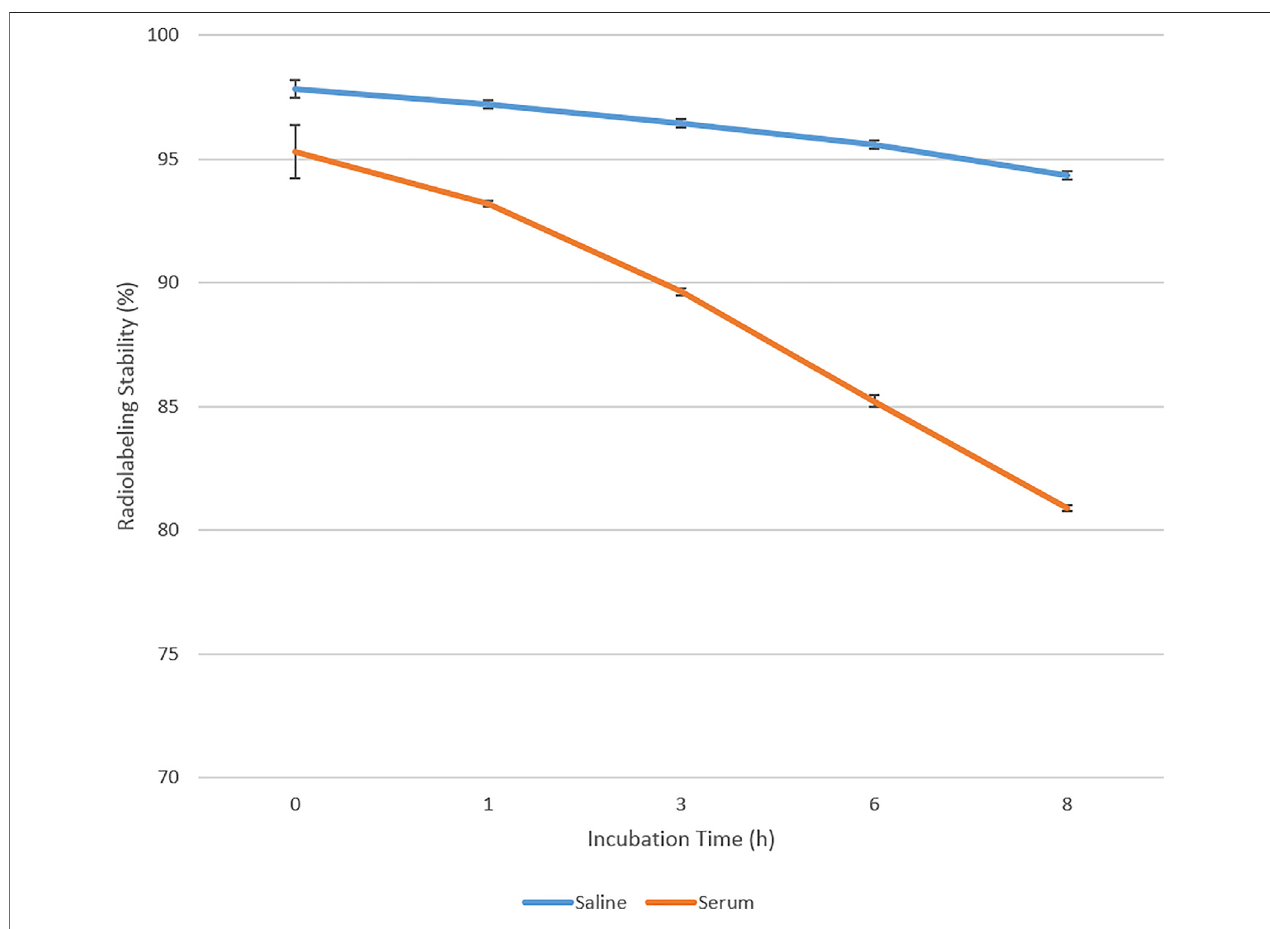
FIGURE 2 | In vitro stability of 99mTc-labeled